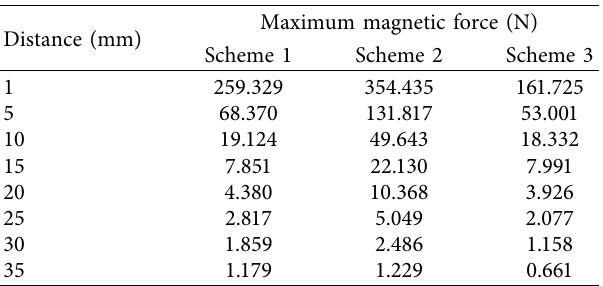
Figure 10: Magnetic flux density norm nephogram of the valve cover when the valve seat consists of two identical shape tile magnets. (a) Scheme 1. (b) Scheme 2. (c) Scheme 3. Table 1: Maximum magnetic force of the valve cover when the valve seat consists of two identical shape tile magnets in three